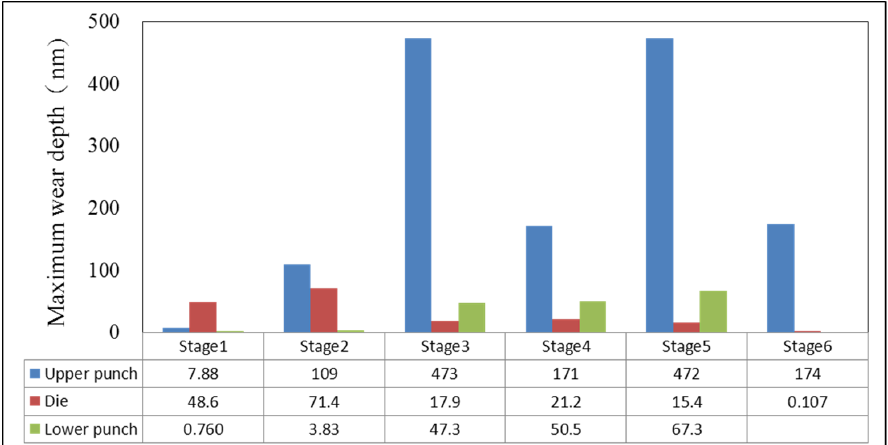
Figure 15. Simulated wear at each stage.